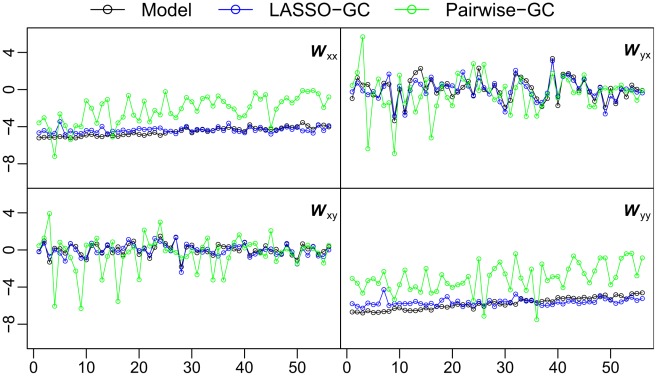
Comparison of LASSO-GC and pairwise-GC methods in recovering the W summary statistic.The GC strength (W summary statistic) in each submatrix, computed directly from the simulation model, is compared with the W statistic estimated by the LASSO-GC and pairwise-GC methods. The estimated LASSO-GC W statistic more closely matches the W statistic of the model across simulation models than does the estimated pairwise-GC W statistic. Since the estimated W statistic is based on t-scores and the W statistic computed directly from the simulation model is based on b coefficient values, both b and t-scores were normalized to standard z-scores before calculating W. The horizontal axis is arranged the same way as in Figure 2.